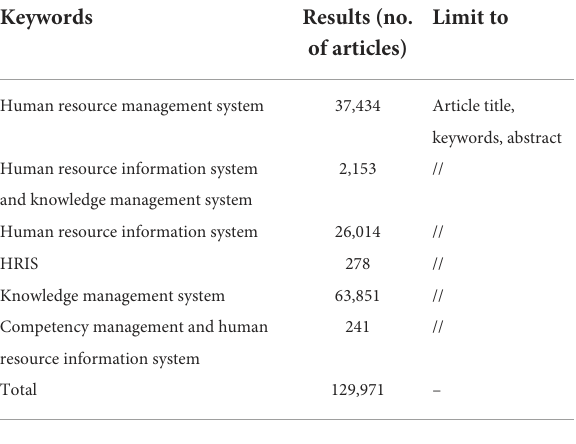
TABLE 1 Initial search results and a number of papers